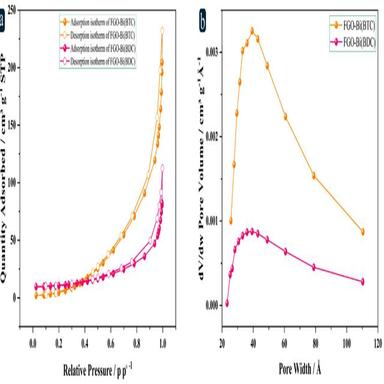
a) N2 adsorption/desorption isotherms, and b) BJH plots of FGO-Bi(BDC) and FGO-Bi(BTC).